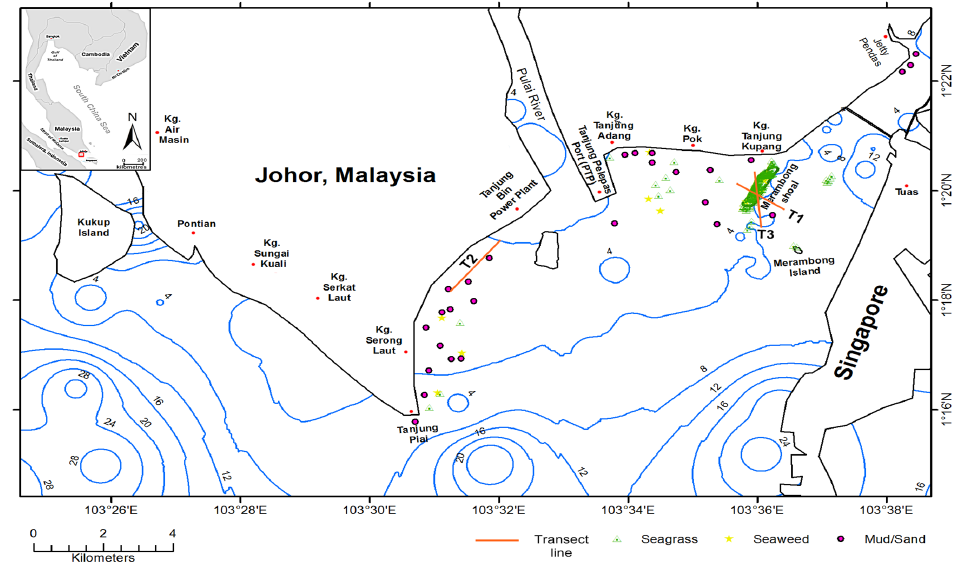
Figure 1. Field samples and location of Merambong shoal. Depth (blue line) is in meter.